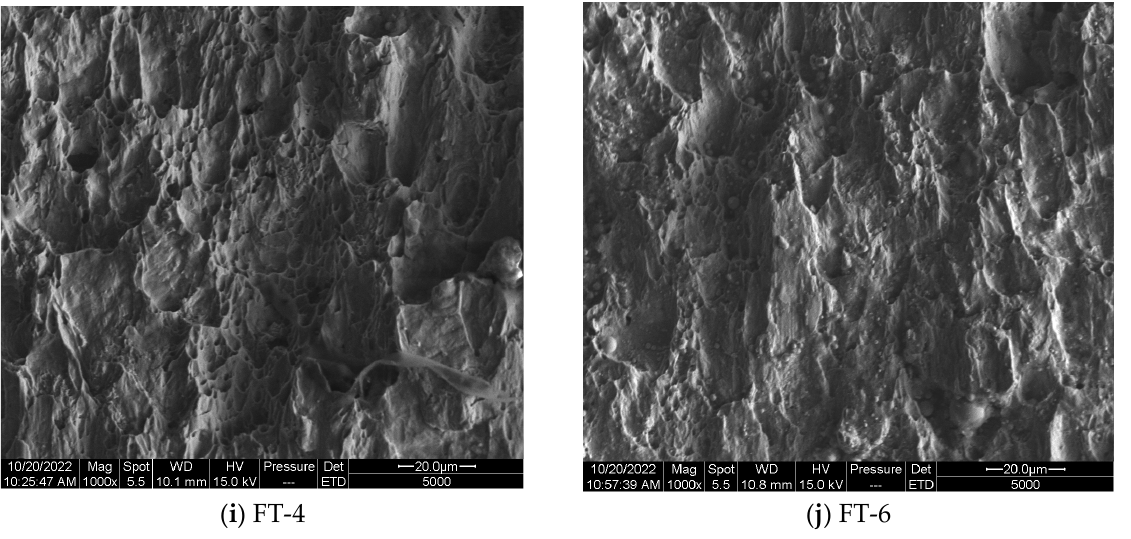
Figure 8. The microscopic fracture characteristics of the ML15 steel as assessed by the scanning electron microscope.